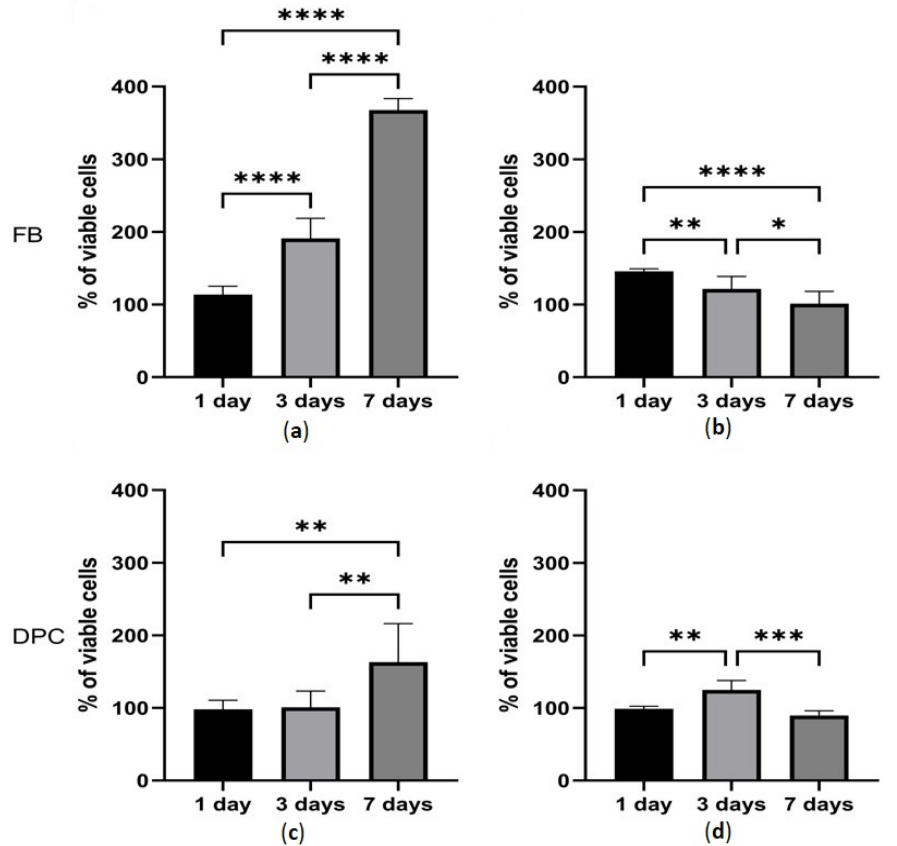
Figure 3. MTT assay. Cell viability for fibroblasts (FB) and dental pulp cells (DPC): ( a ) indirect treatment of FB; ( b ) direct contact of FB with the Cu-Al-Ni disc; ( c ) indirect treatment on DPS; ( d ) direct contact DPC with the Cu-Al-Ni disc, measured after the 1st,3rd and 7th days.* p < 0.05, ** p < 0.01, *** p < 0.001, **** p < 0.0001. Direct exposure of fibroblasts to the tested Cu-Al-Ni discs led to increased cell pro- liferation after the firstday (mean = 145%) and then to a decrease after the third(mean = 121%) and seventhdays (mean = 101%) (Figure 3b).